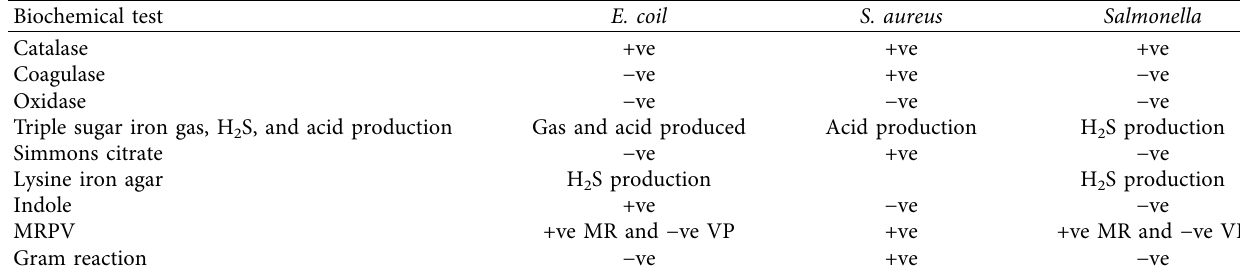
Table 6: Biochemical test for pathogenic